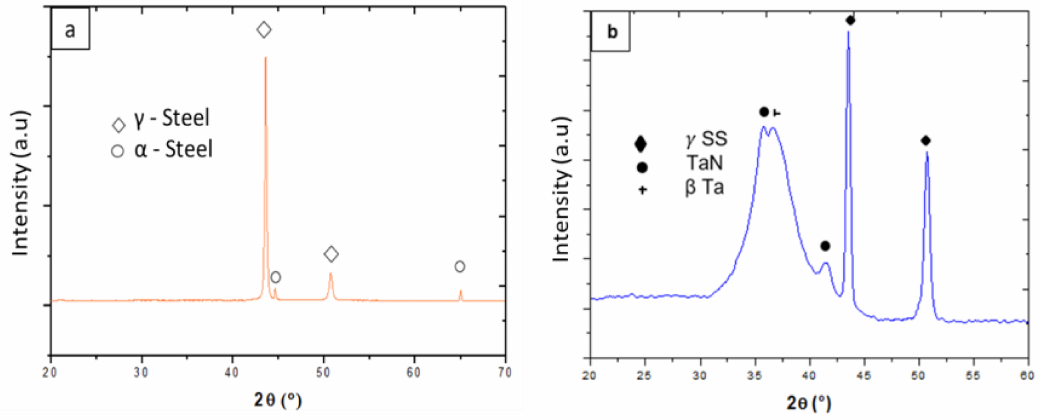
Figure 6. XRD of: ( a ) SS sample and ( b )